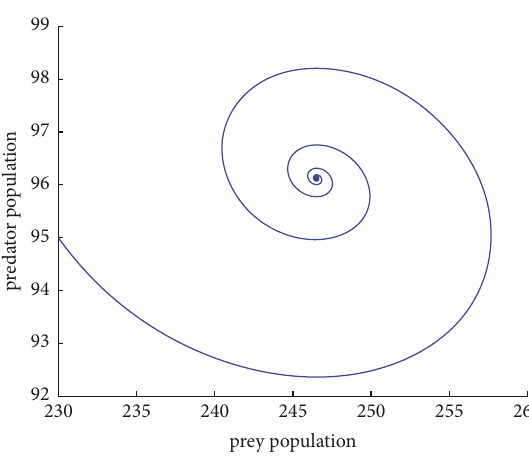
Figure 14: The phase portrait of delayed model (3) with the time delays 𝜏 1 = 0.1 and 𝜏 2 = 0 . The parameters are taken as 𝑥(0) = 230 , 𝑦(0) = 95 , 𝐴 = 0.01 , 𝑟 = 2.65 , 𝐾 = 900 , 𝑎 = 0.02 , 𝑐 = 0.215 , and 𝑚 = 1.06 ; 𝐸 = (𝑥 ,𝑦 ) is locally asymptotically stable, with no limit ∗ ∗ ∗ cycle.